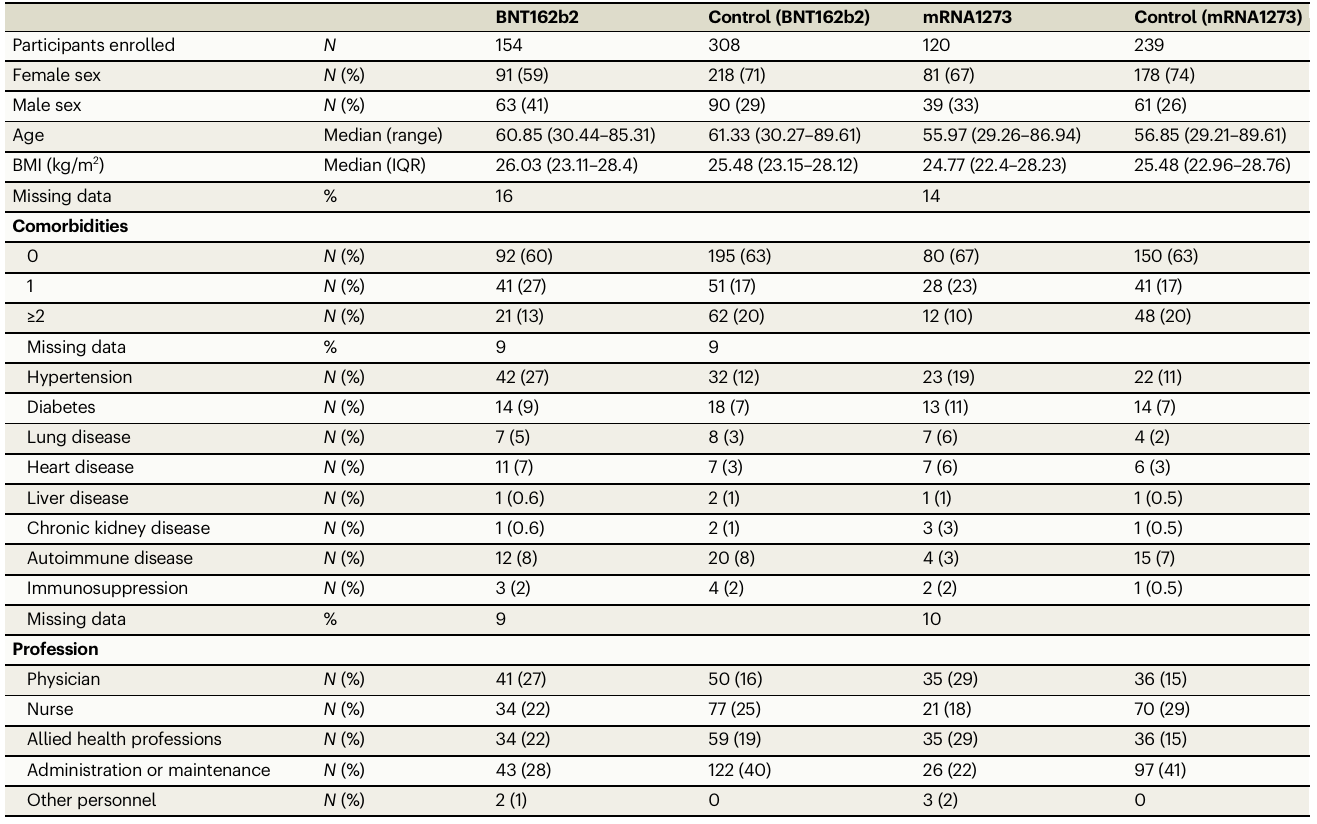
Table 1 | Baseline characteristics of the study